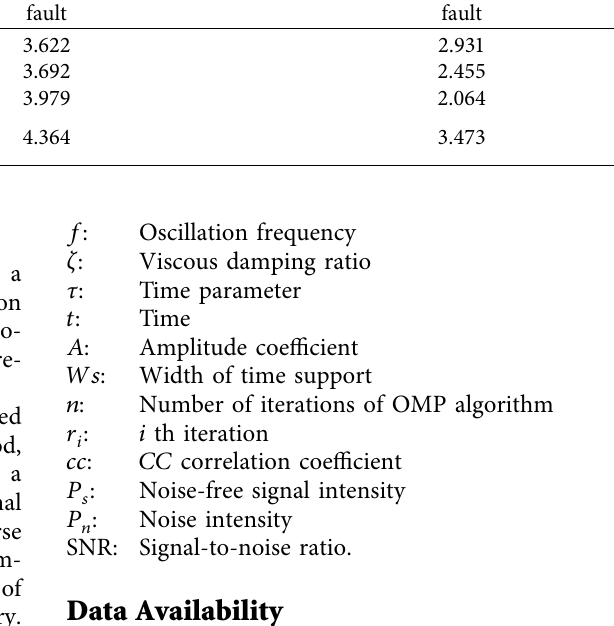
Table 4: Normalized amplitude of fault characteristic frequency. Normalized amplitude of inner ring